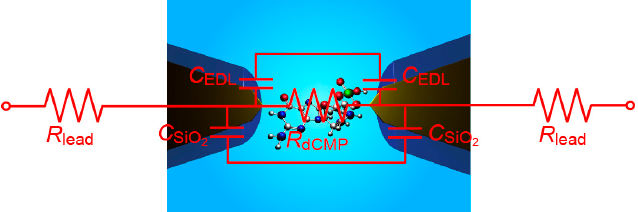
Figure 9. Rough circuit model of the SiO 2 /Au nanoelectrodes consisting of the single-molecule resistance ( R dCMP ), the capacitance of the electric double layers ( C EDL ) and SiO 2 layers ( C SiO2 ), and the Au lead resistance ( R lead ).